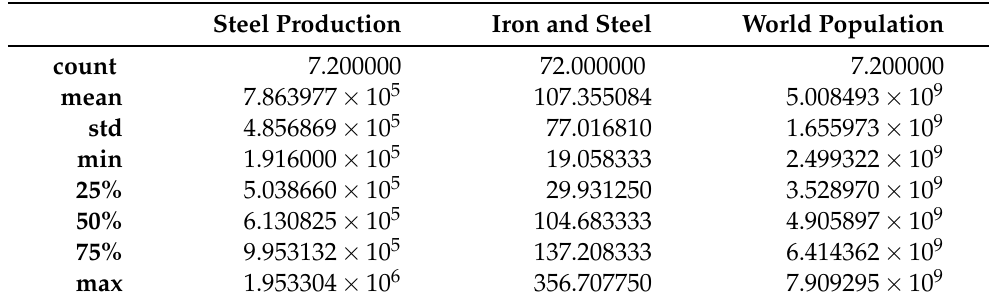
Table 3. Description of the variables steel production, producer price index by commodity, and world